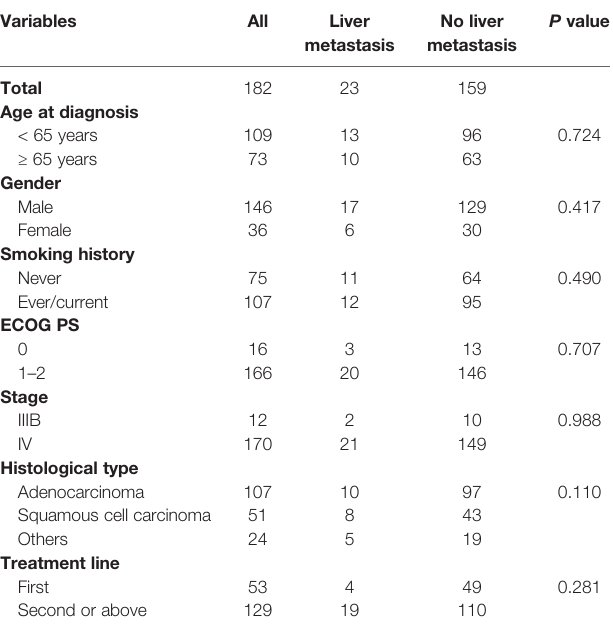
TABLE 3 | Baseline characteristics of the population from real-world cohort.